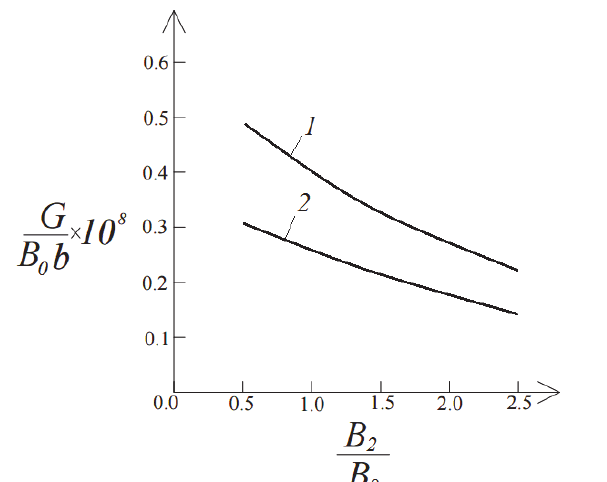
Figure 7: The strain energy release rate in non-dimensional form presented as a function of 2 0 / B B ratio (curve 1 – at